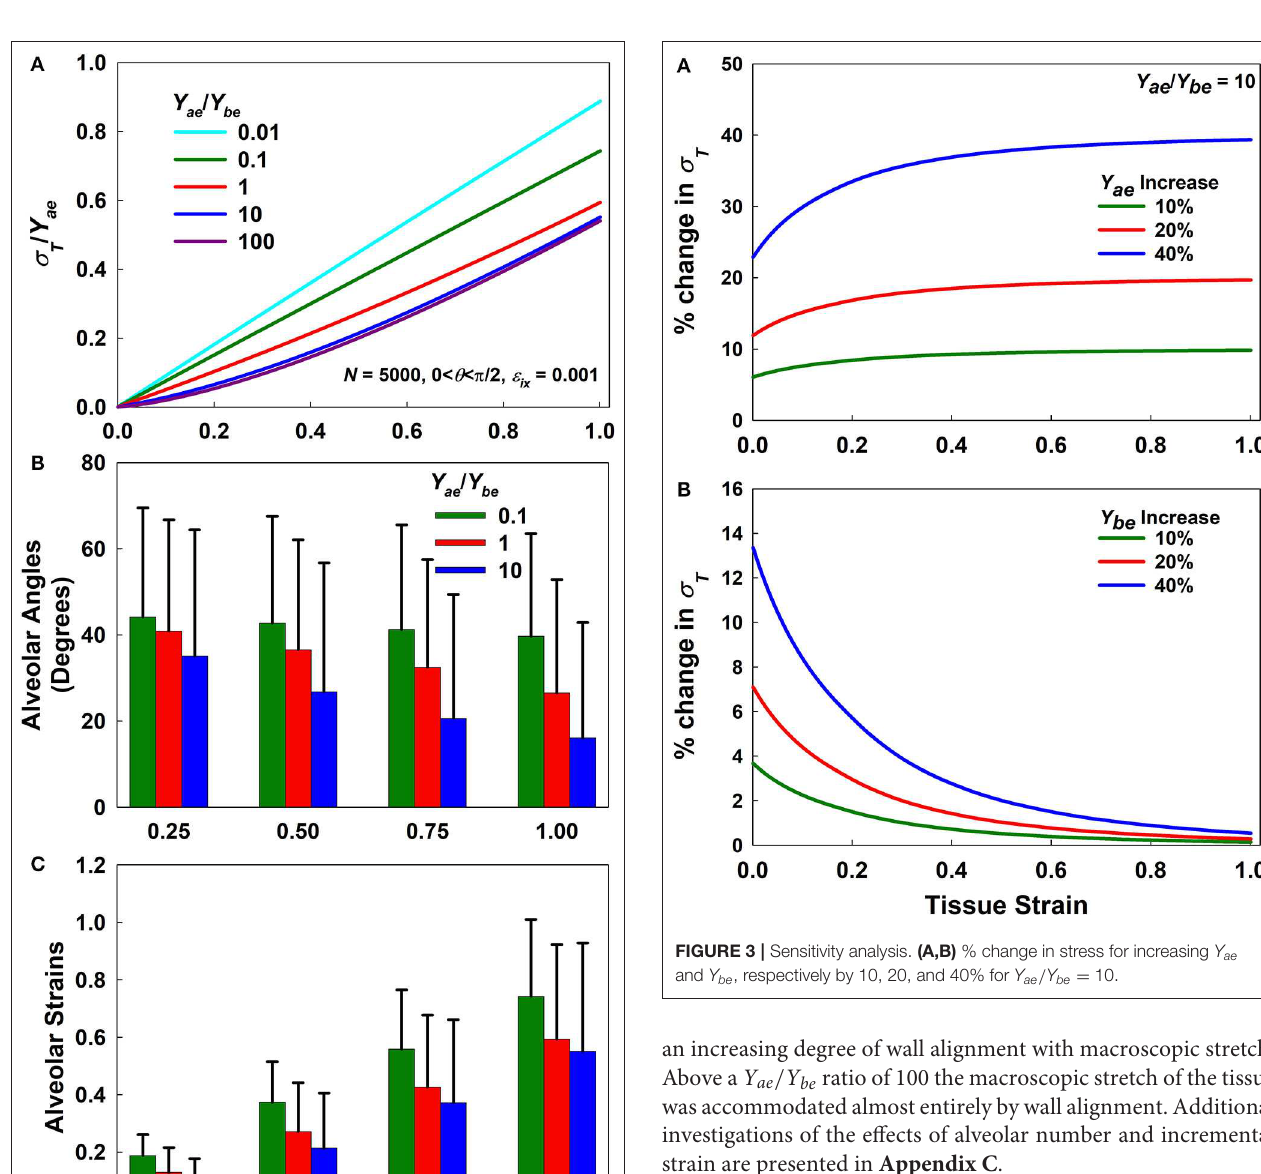
an increasing degree of wall alignment with macroscopic